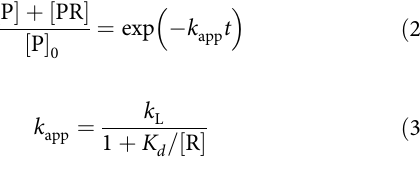
Table 1 Kinetic and binding parameters of labelling reagents for FKBP12 and eDHFR Protein Reagent